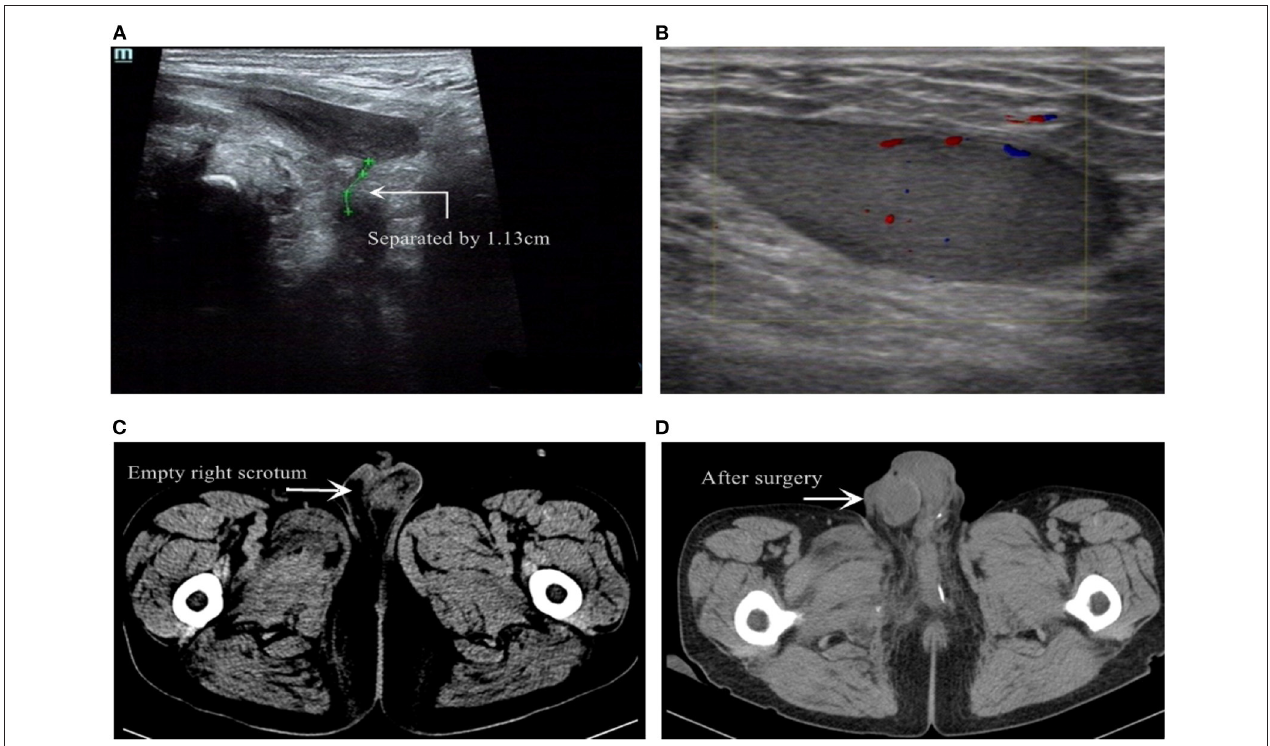
FIGURE 2 | (A) Transpelvic ultrasound examination revealed membranous urethral rupture. (B) Color Doppler US image of the inguinal mass revealed a intact shape of testicle with blood supply. (C) Pelvic CT showed the swollen scrotum and the empty right scrotum. (D) Re-examination of pelvic CT after